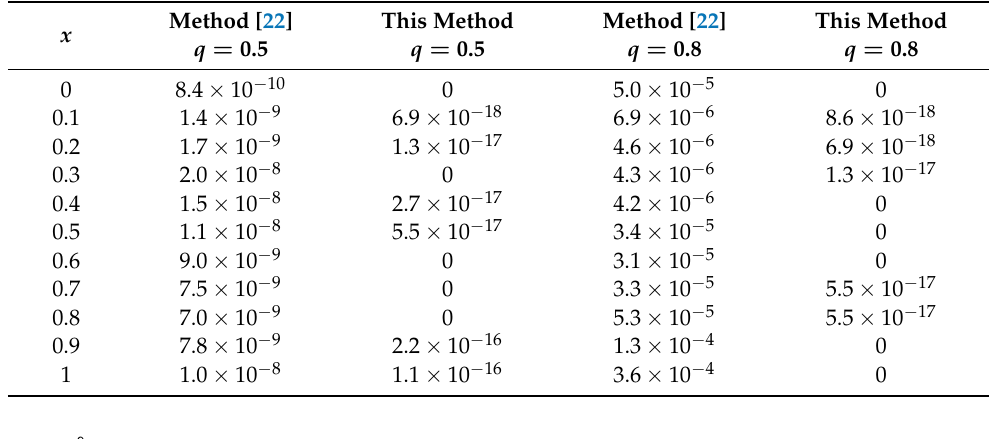
Table 2. Absolute errors for N = 1 and M = 4, α = 0.5 in Example 4.